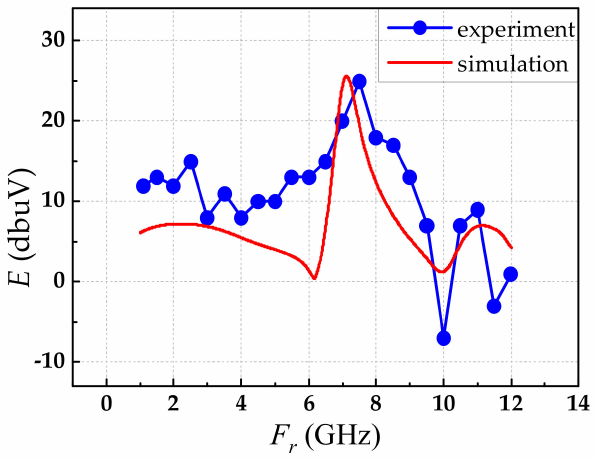
Figure 10. The frequency response of the experiment and